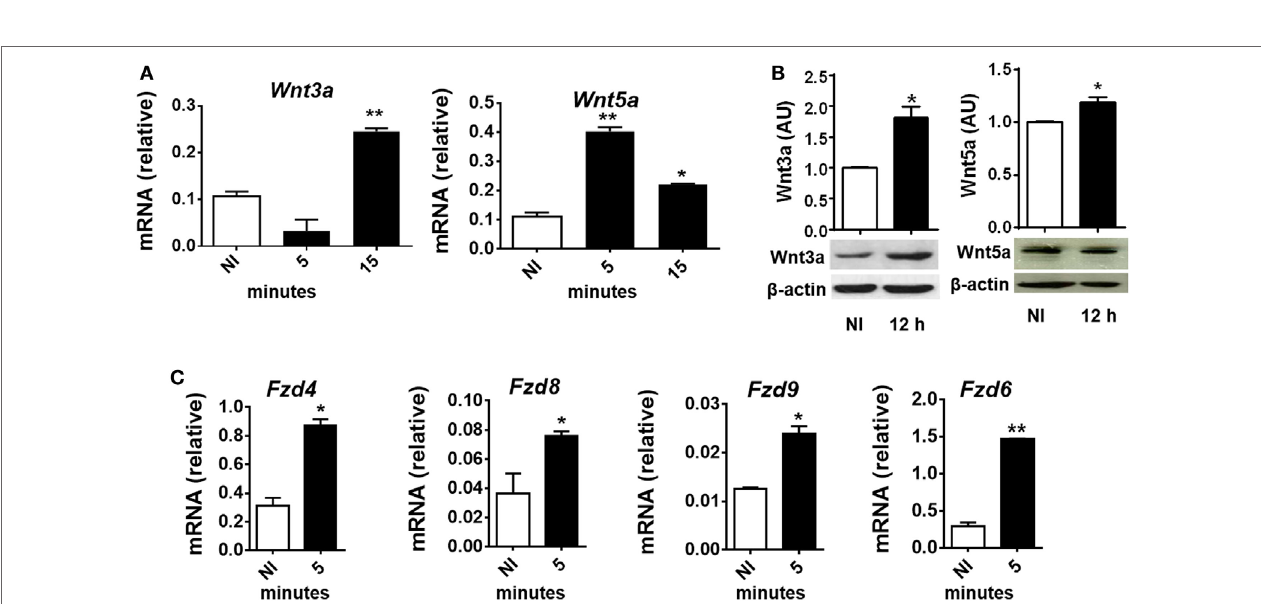
FigUre 2 | In vitro Trypanosoma cruzi infection induces expression of Wnt proteins, Frizzled (Fzd) receptors, and β -catenin macrophages. Bone marrow-derived macrophages were in vitro infected with T. cruzi trypomastigotes or left uninfected (NI) and then evaluated for expression of Wnt proteins and Fzd receptors at different times post-infection (pi). (a) Expression of Wnt3a and Wnt5a mRNA (relative to β -actin) was determined by quantitative real-time-PCR. (B) The relative abundance of Wnt3, Wnt5a, and β -actin in the cell lysates were determined by Western blot and densitometry at 12 h pi. Representative Western blot and the ratio of Wnt3a or Wnt5a to β -actin are shown. (c) Expression of Fzd4, Fzd8, Fzd9, and Fzd6 mRNA (relative to β -actin) was determined by q-PCR. The results are expressed as the average of three independent experiments ± SEM. Abbreviation: AU, arbitrary units (* P < 0.05 and ** P < 0.01).